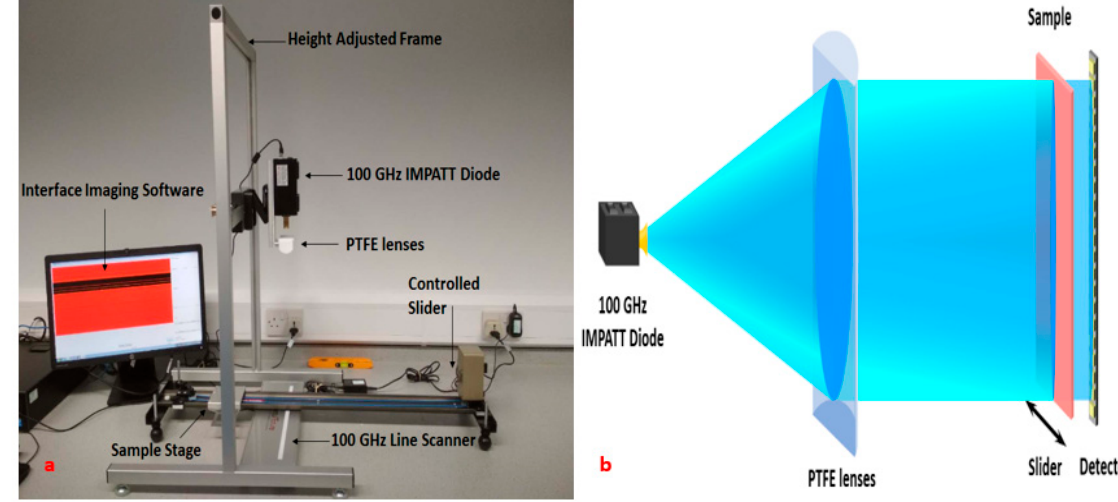
Figure 2. ( a ) Photograph and ( b ) schematic plot of the 100 GHz line scanning imager.